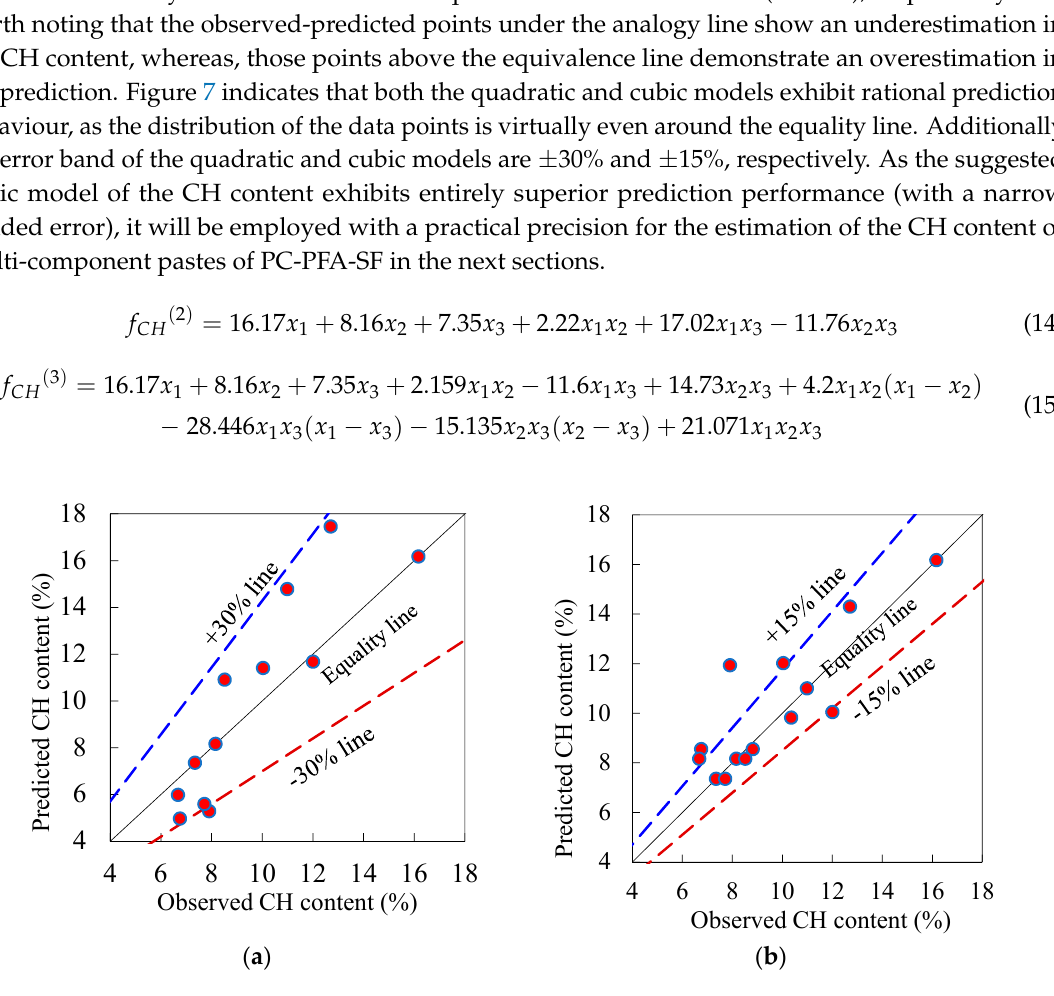
Figure 7. Actual vs. predicted 28-day CH content (%) of control and ternary blended pastes: ( a ) Quadratic model (Equation (14)) and ( b ) Cubic model (Equation (15)).